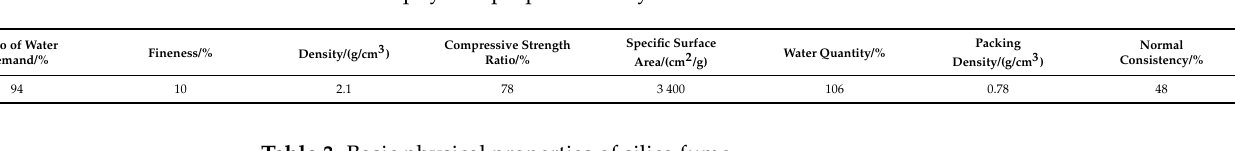
Table 3. Basic physical properties of silica fume.